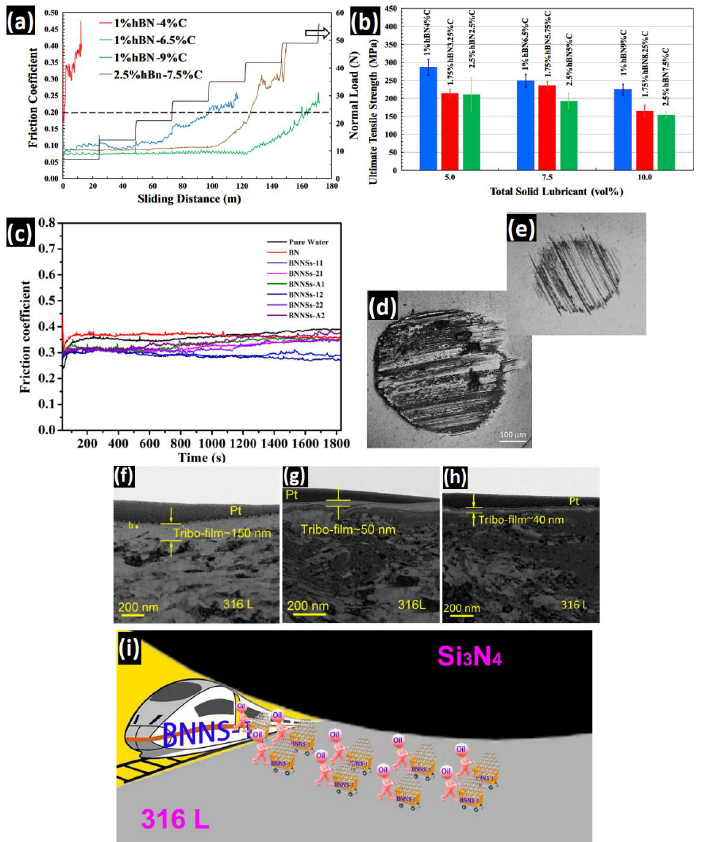
Figure 20. ( a ) Typical evolution of the COF with sliding distance, comparing the effect of total solid lubricant amount (5, 7.5, and 10 vol.%) and effect of h-BN content (1 and 2.5 vol.%), and ( b ) ultimate tensile strength of the sintered composites as function of the solid lubricant content (Reprinted with permission from Elsevier, Copyrights 2017) [163]. ( c ) COF curves of pure water, 0.5 mg mL − 1 h-BN / water and BNNSs / water dispersions. The tribological tests were carried out at 100 N and 25 Hz, with an amplitude of 1 mm (Reprinted with permission from Elsevier, Copyrights 2019) [169]. Optical microscopy images of wear scars of the steel balls tested in ( d ) neat base oil and ( e ) base oil with graphene / h-BN composite nanosheets (four-ball method, 1770 rpm, 392 N, 10 s) (Reprinted with permission from WILEY-VCH, Copyrights 2018) [170]. Wear surface of ( f ) BNNS-1, ( g ) h-BN, and ( h ) BNNS-2; ( i ) illustration of friction mechanism (Reprinted with permission from Elsevier, Copyrights 2020)